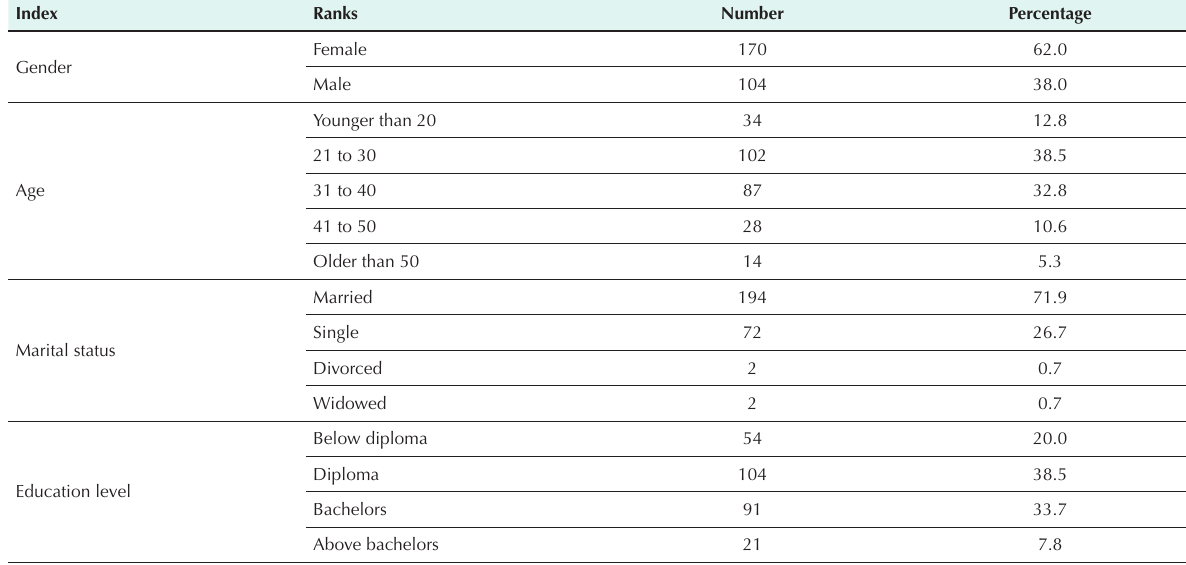
Table 1. Distribution of Relative and Absolute Frequencies in Terms of Demographic Indices